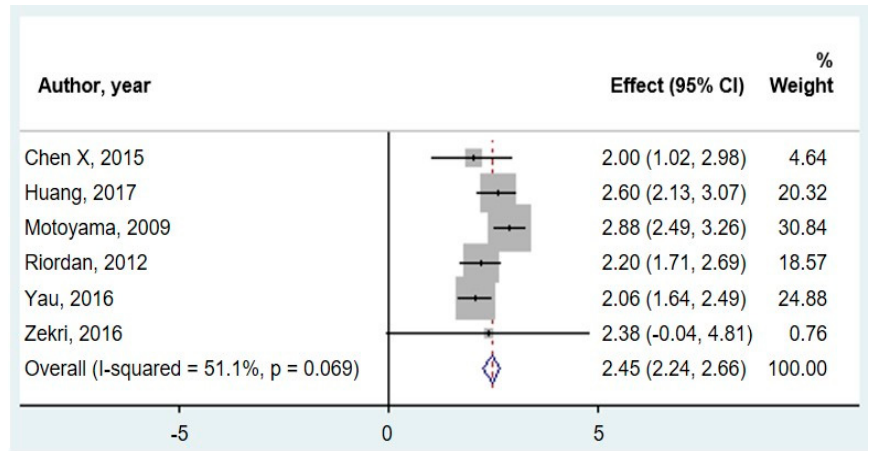
Figure 2. Forest plot for the meta-analysis of miR-20a expression fold change in CRC versus controls across tissue types.